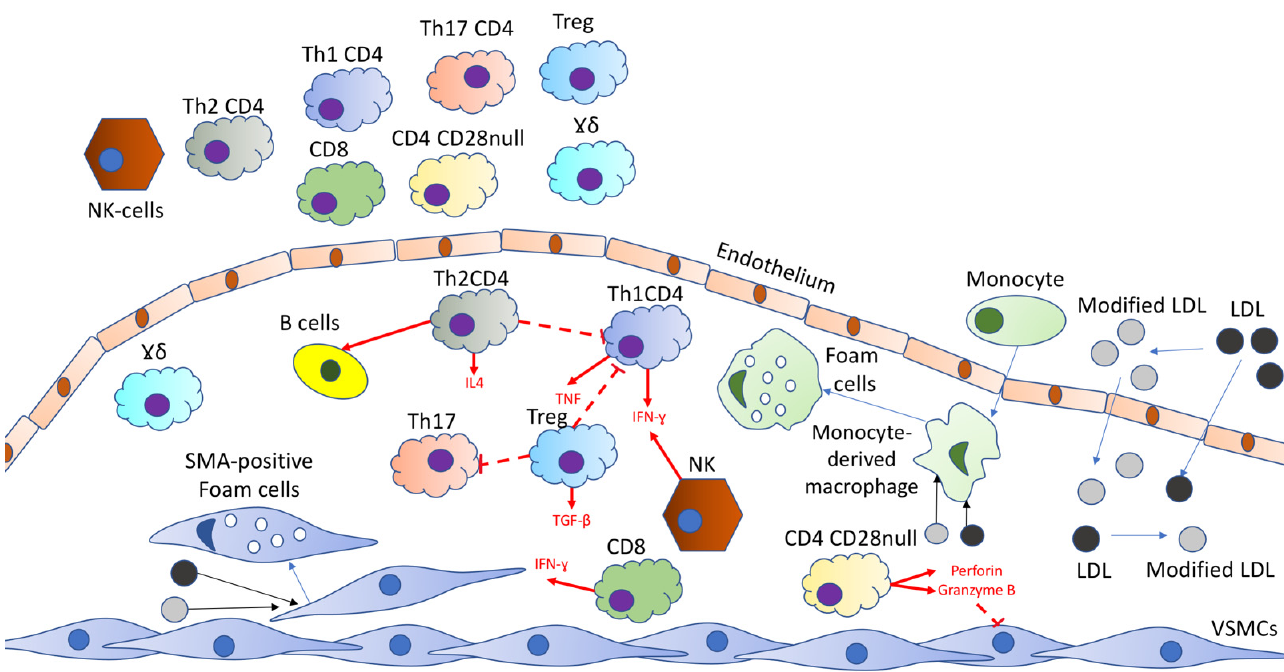
Figure 1. Various types of T cells are attracted to the atherosclerotic lesion site by the chemokines released by the activated endothelial cells. IFN γ (interferon-gamma) is produced by Th1 cells and has proatherogenic features. It inhibits the proliferation of smooth muscle cells, decreases collagen production, and activates macrophages. IL-4 (interleukin-4) is produced by Th2 cells and has atheroprotective effects mediated by the ability to inhibit Th1 cells. Granzyme B and perforin, which are released by CD4 + CD28nullT-cells can damage vascular wall cells. CD8 + T-cells produce proatherogenic IFN γ or cause an atheroprotective effect via decreasing macrophage content in the plaque. Treg cells release TGF- β (transforming growth factor β ), contributing to Th1 and Th17 response inhibition, as well as enhancing smooth muscle cell proliferation. NK-T cells are potentially involved in the destabilization of atherosclerotic plaques. No exact roles for Th17 and γδ T-cells, which are present in plaque, have yet been established.